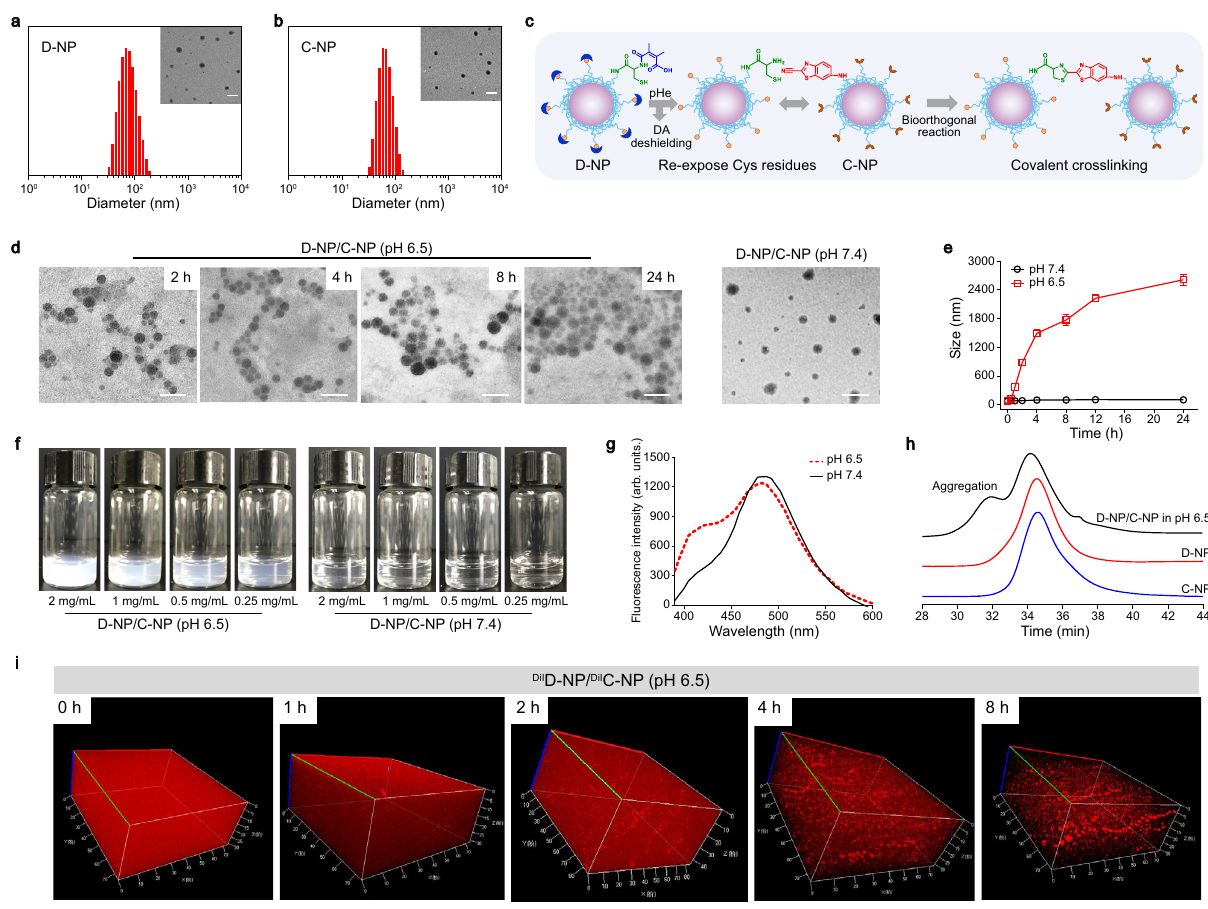
Fig. 2 Construction and characterization of the bioorthogonal in situ-assembled nanomedicines under acidic conditions. a , b Average hydrodynamic sizes of a D-NP and b C-NP determined by DLS, demonstrating their similar size of approximately 65 nm ( n = 3). The inset images are representative TEM images of D-NP and C-NP, Scale bar, 200 nm. Experiments were repeated twice. c Schematic illustrating the bioorthogonal in situ assembly of D-NP/C-NP in the acidic tumor microenvironment. d TEM images of D-NP/C-NP incubated under acidic conditions for various lengths of time. D-NP/C-NP incubated at pH 7.4 for 24h was used as a control formulation. Scale bar, 200 nm. Experiments were repeated twice. e DLS measurements of the hydrodynamic diameters of D-NP/C-NP after incubation under acidic conditions for various lengths of time. Data are presented as the mean ± s.d. ( n = 3). f Photographs of the D-NP/C-NP aqueous solutions after incubation at pH 6.5 or 7.4 for 2 h at various NP concentrations. Experiments were repeated twice. g Fluorescence spectra of the D-NP/C-NP aqueous solutions after incubation at pH 6.5 or 7.4 for 2 h. Experiments were repeated twice. h GPC analysis of the freeze-dried D-NP/C-NP after coincubation at pH 6.5 for 2 h. Freeze-dried D-NP and C-NP were used as control formulations. Experiments were repeated twice. i 3D CLSM images of the D-NP/C-NP aqueous solutions at pH 6.5 after incubation for various lengths of time. D-NP and C-NP were labeled with DiI. A representative image from one of fi ve independent fi elds of view in a single experiment. DA: 2, 3-dimethylmaleic anhydride, pHe: tumor acidity, Cys: cysteine, Arb. units.: arbitrary units, DiI: 1,1'-Dioctadecyl-3,3,3',3'-tetramethylindocarbocyanine perchlorate. Source data are provided as a Source Data fi